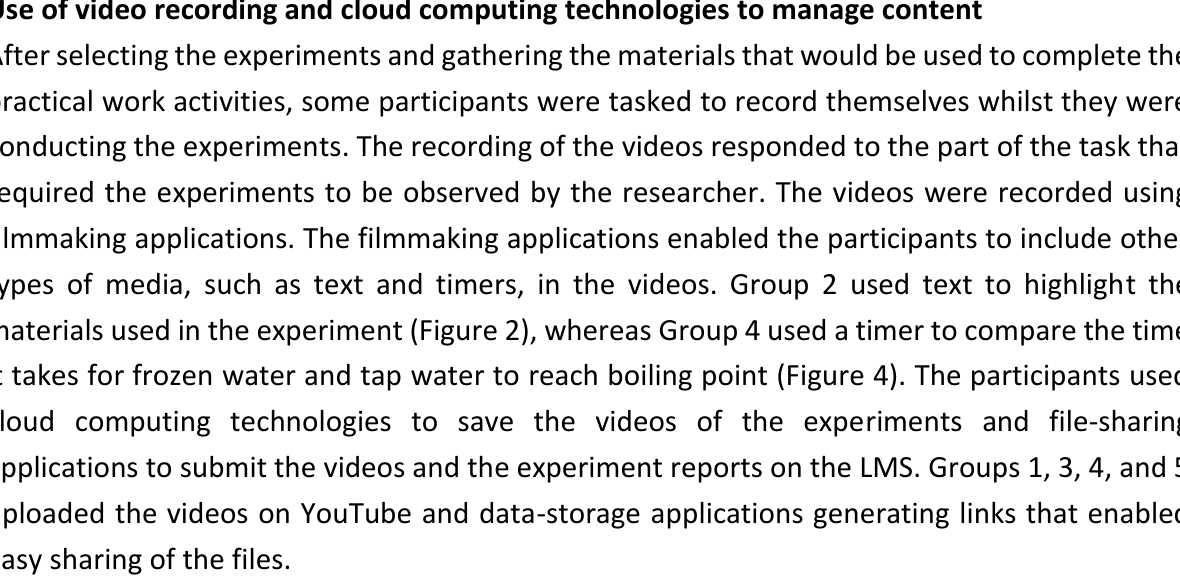
Figure 6. (a) List of materials for Group 1’s experiment and (b) improvised materials Similarly, Group 2 used drinking glasses, whilst Group 4 used an electric stove from the kitchen in place of beakers and laboratory heaters and burners, respectively, as shown is Figure